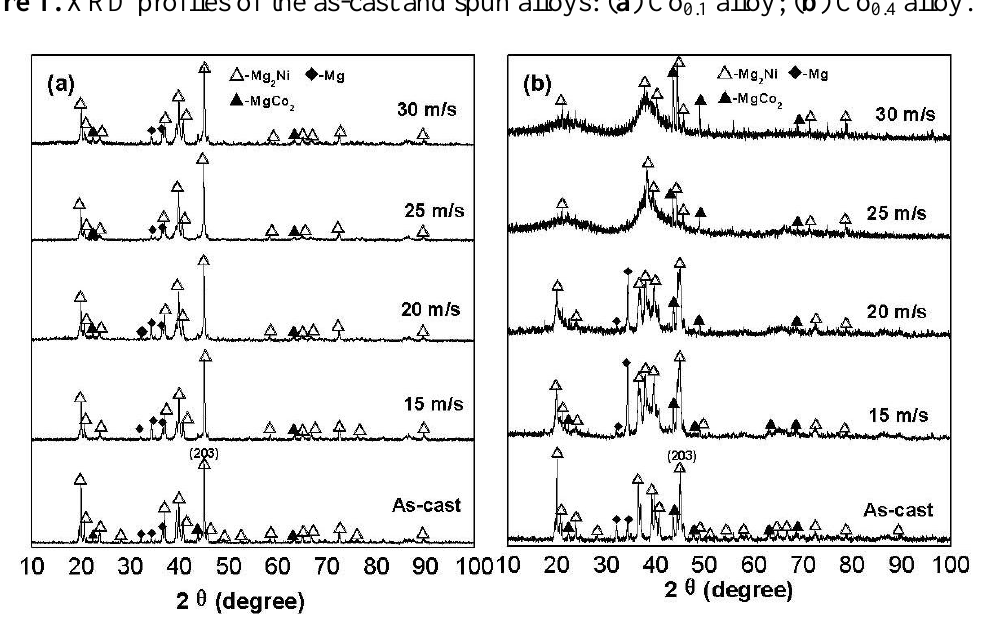
Figure 1. XRD profiles of the as-cast and spun alloys: ( a ) Co